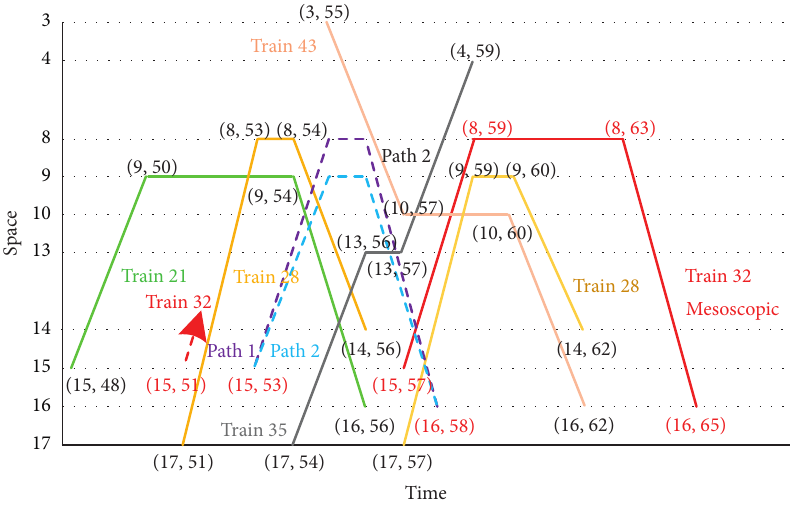
Figure 9: Comparison of the results from the mesoscopic and macroscopic